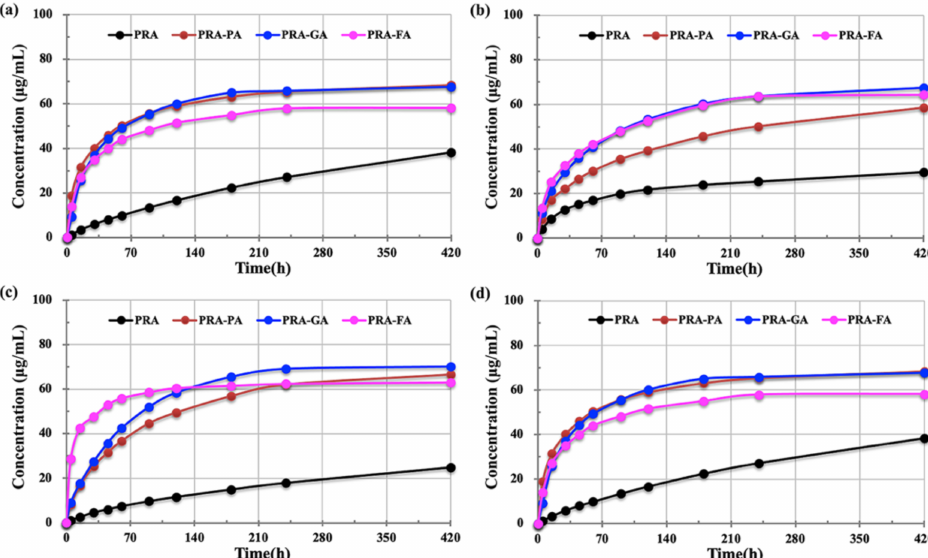
Figure 9. Solubility results of cocrystals of PRA-PA, PRA-GA and PRA-FA compared with PRA: ( a ) aqueous hydrochloric acid solution (pH = 1.2); ( b ) acetate buffer (pH = 4.5); ( c ) phosphate buffer (pH = 6.8); ( d ) water.